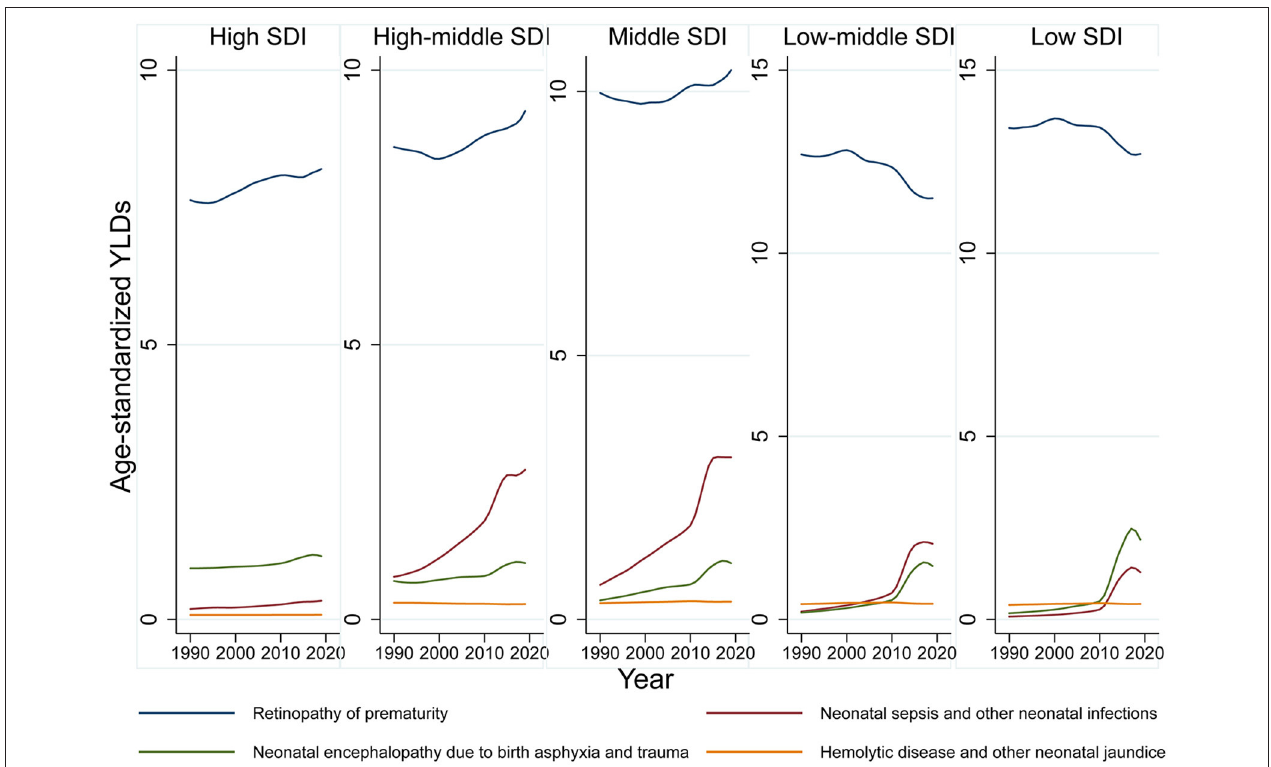
FIGURE 2 | Age-standardized, cause-specific YLD rate due to neonatal disorders.